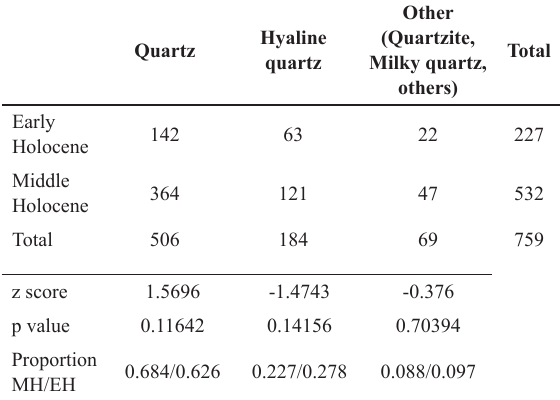
Number of elements, Z-test results (z score and p value) and proportion between Middle Holocene (MH) and Early Holocene (EH) raw material types.